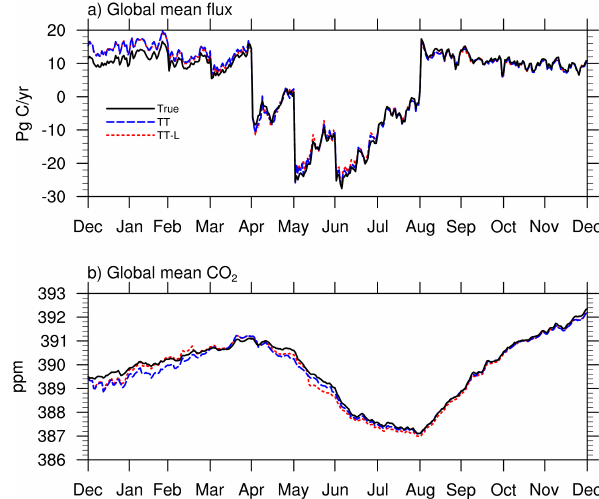
Figure 13. Time series of the daily global mean (a) CO 2 surface fluxes and (b) CO 2 concentrations from the “true” and the TT (Tan- Tracker) assimilations with ensemble numbers N = 106 and 150, respectively, from 1 January to 31 December 2010.